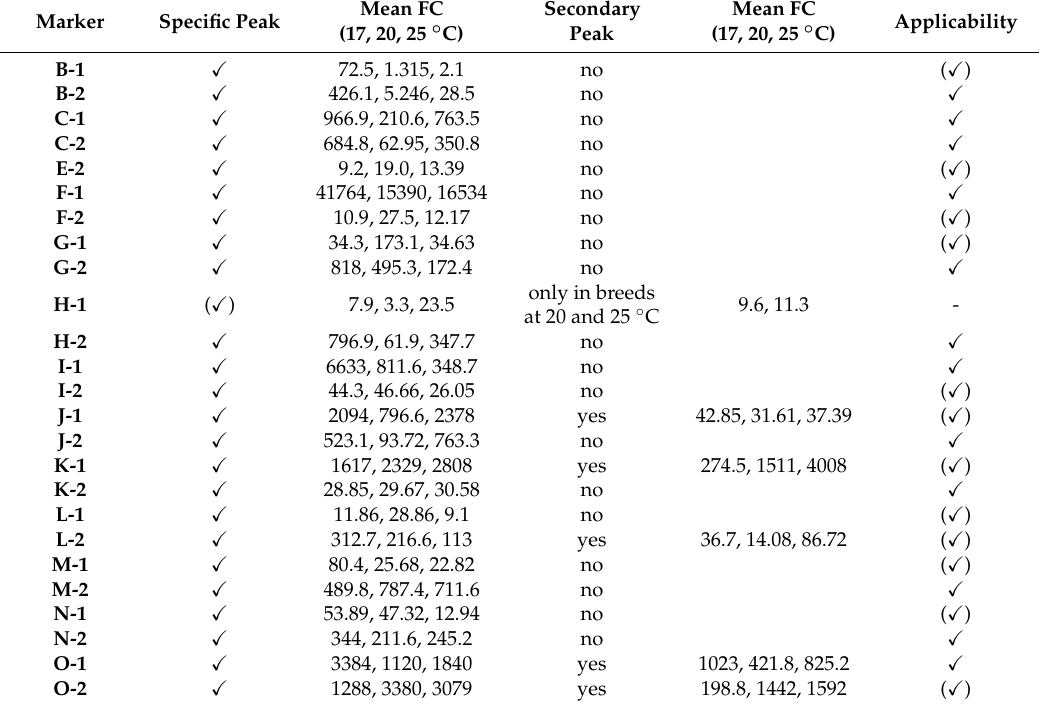
Table 5. Summary of the characteristics of the investigated markers regarding their applicability: specific peaks corresponding to the developmental progress they are designed for. Mean FC compared to the white prepupal stage (landmark A). Occurrence of a secondary peak and the mean FC value compared to the white prepupal stage (landmark A). Recommendation for the applicability according to their characteristics: Checkmarks indicate a sharp demarcation of gene expression at the corresponding stage of development. (Checkmarks) indicate a weaker demarcation of gene expression at the corresponding stage of